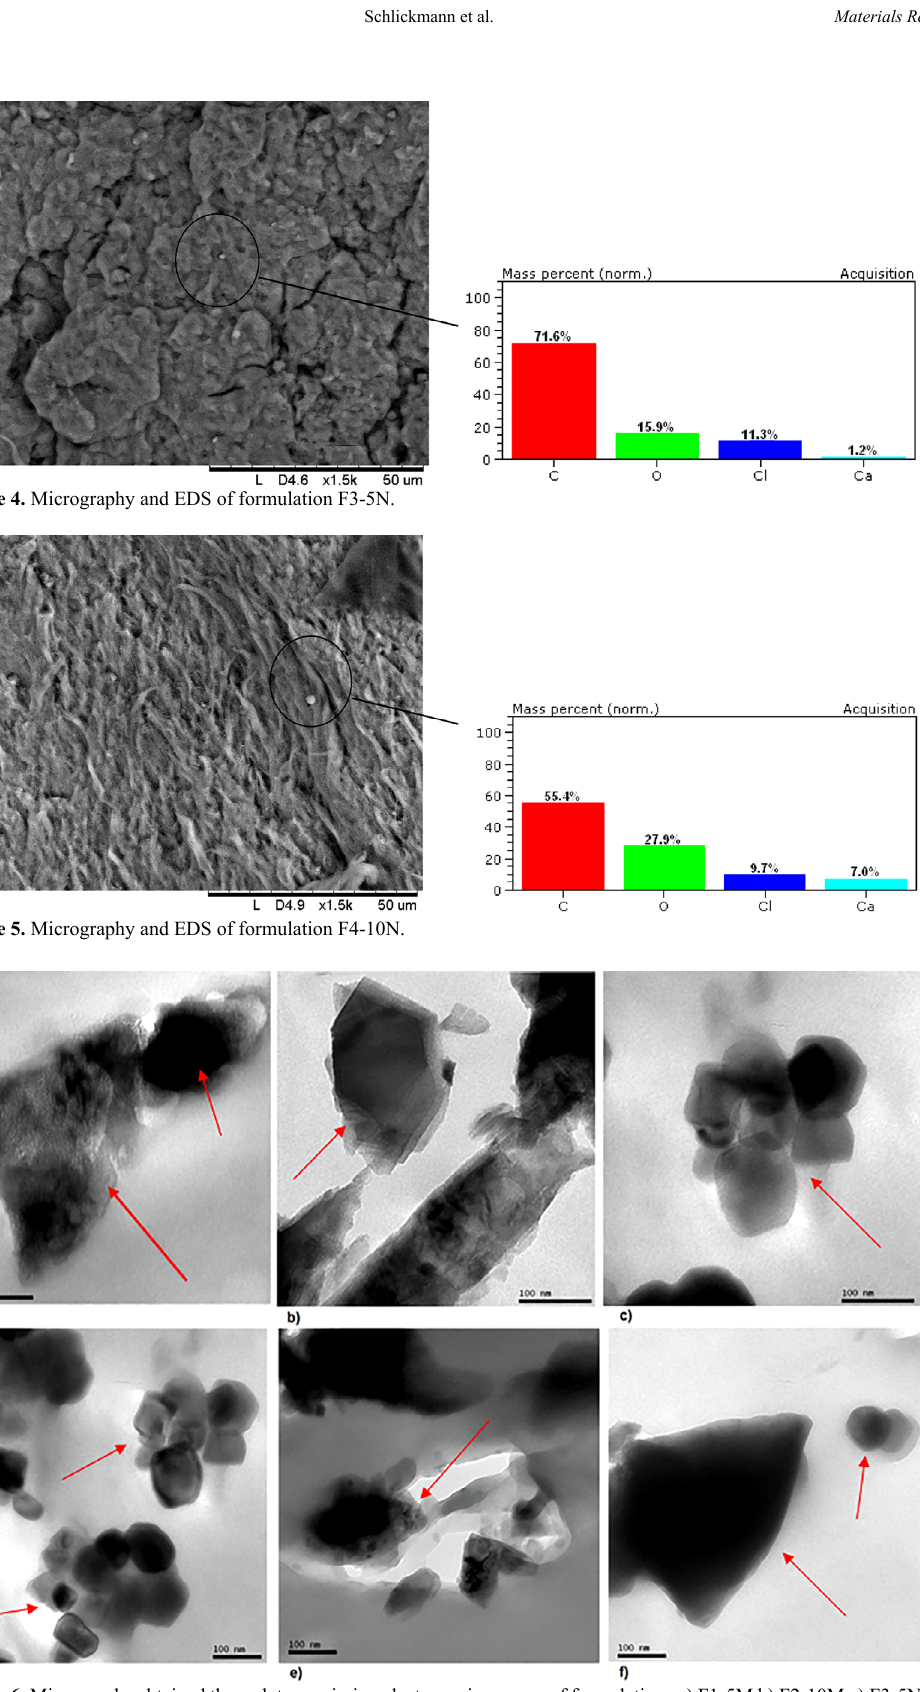
Figure 6. Micrographs obtained through transmission electron microscopy of formulations a) F1-5M b) F2-10M c) F3-5N d) F4-10N d) F5-5MOD e)